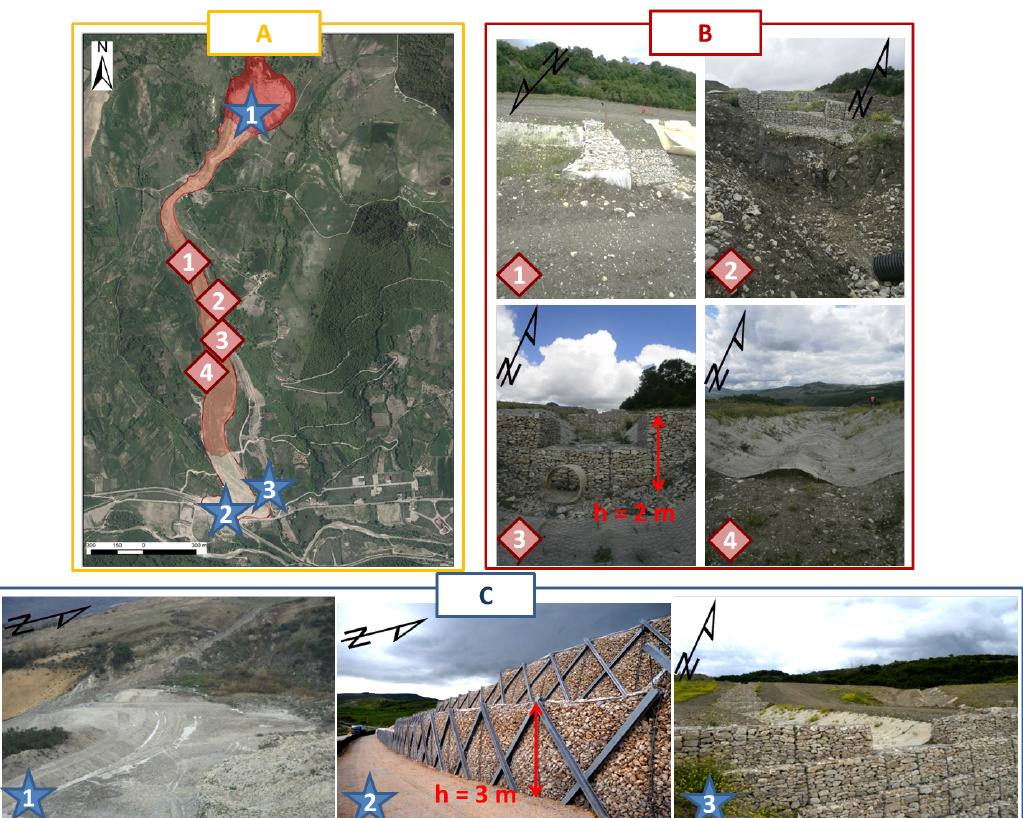
Figure 13. (a) Location of some remedial works along the landslide; (b) various forms of damage to the weirs (1, 2 and 3) and to the channel geotextile filter (4). The damages were caused by the slow and constant displacement located in the E sector. (c) Photos showing the primary important completed works: (1) drainage systems at the bottom of the main scarp, (2) gabion rock toe buttress and drain, (3) surface drains coupled with deep trench drains and (d) Rio Nocelle water